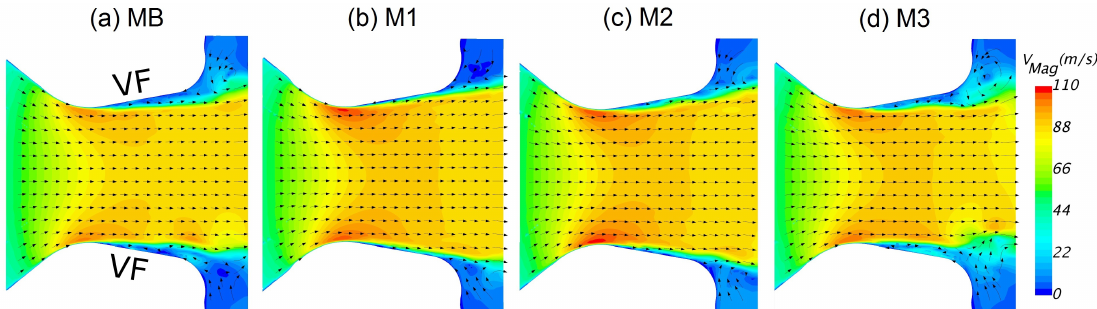
Figure 9. Velocity magnitude contours with slashed streamlines in the mid-coronal plane of the glottal duct of different meshes MB–M3 (parts ( a – d )) at the time instance of maximum glottal divergent angle (0.58 T).